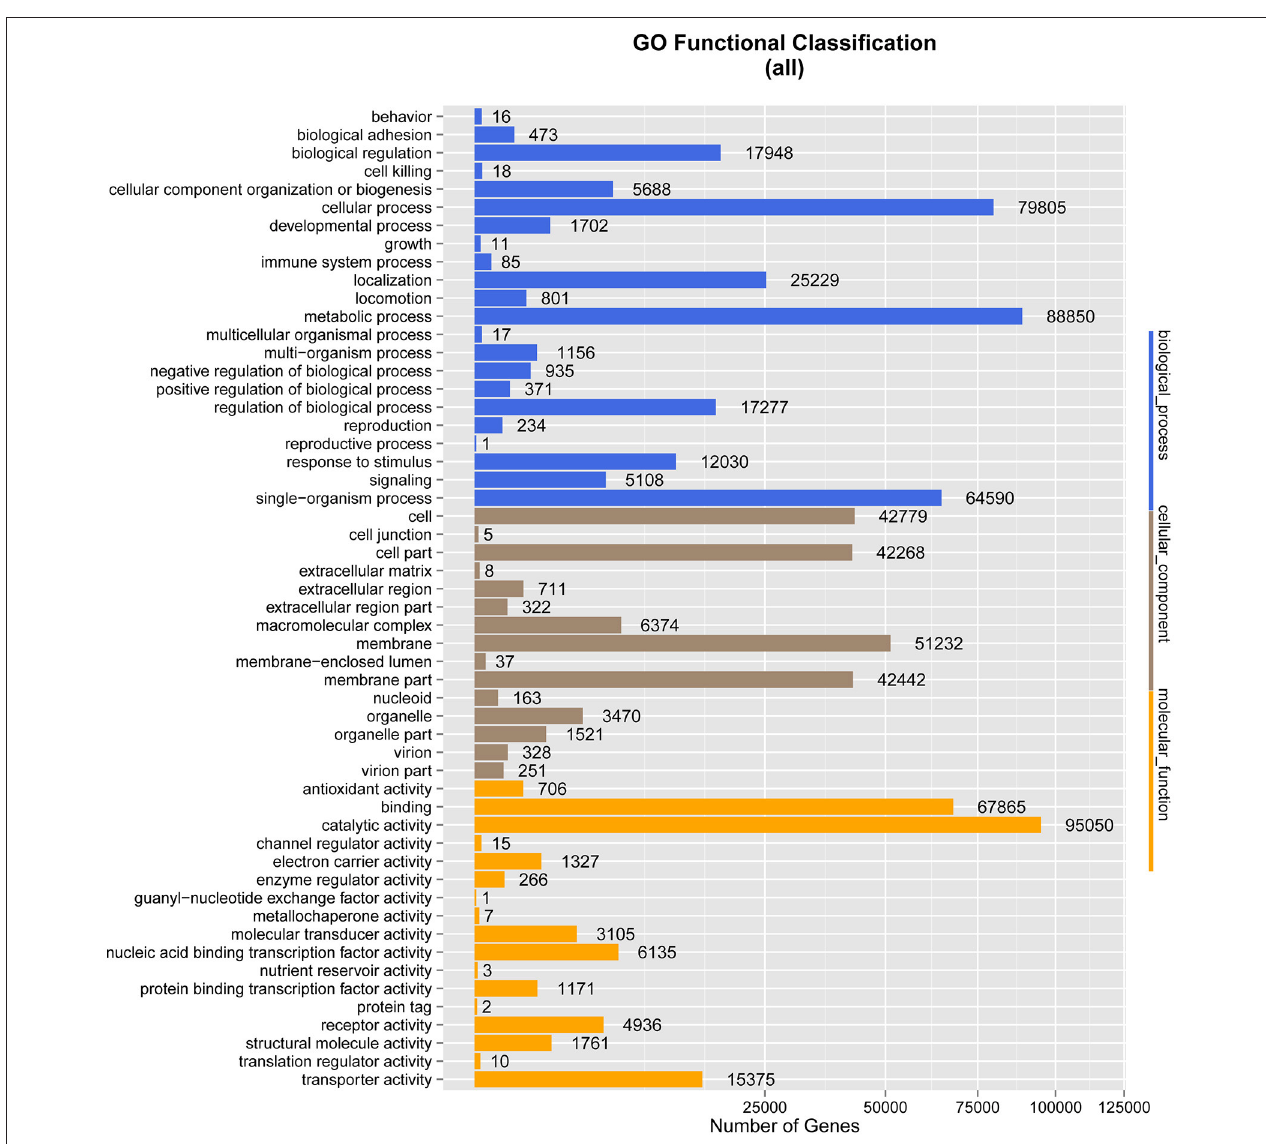
FIGURE 3 | Gene Ontology (GO) classification analysis of genes. The X-axis shows the GO function classes. The right side of the Y-axis shows the number of genes having that GO function, and the left side shows the percentage.